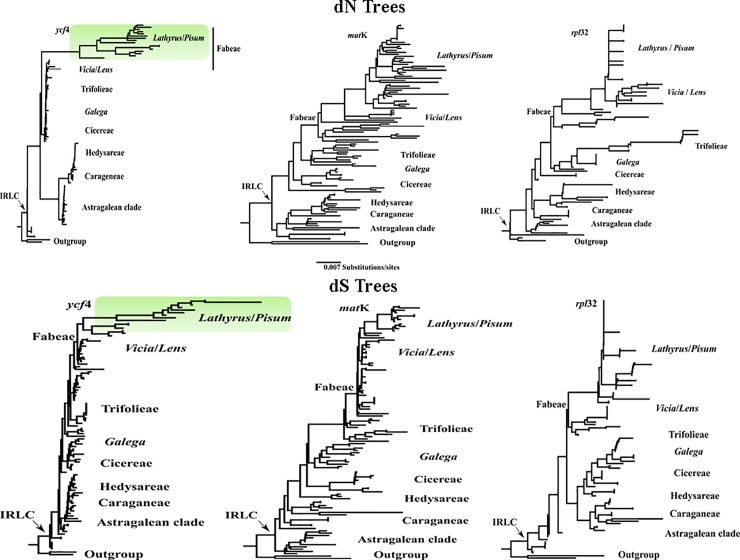
Synonymous and nonsynonymous divergence in IRLC ycf4 sequences.All trees are drawn to the same scale. Green branches in the dN and dS trees indicate taxa in which ycf4 gene represents positive selection and acceleration in evolutionary rate. Trees for matK and rpl32 genes do not show comparable rate at either synonymous or nonsynonymous divergence.